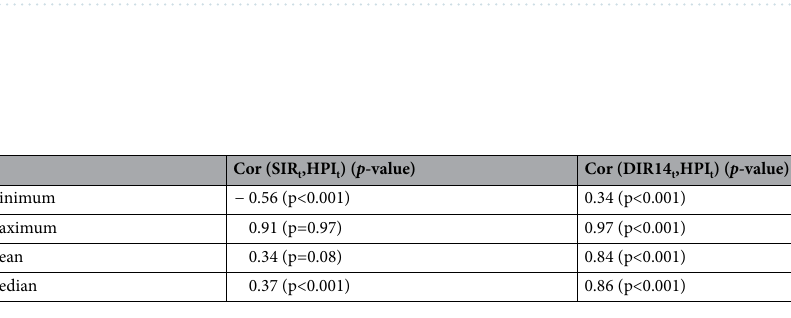
Figure 6. Spatial distribution of SIR, DIR14 and HPI, 28/01/2020, Porto area.